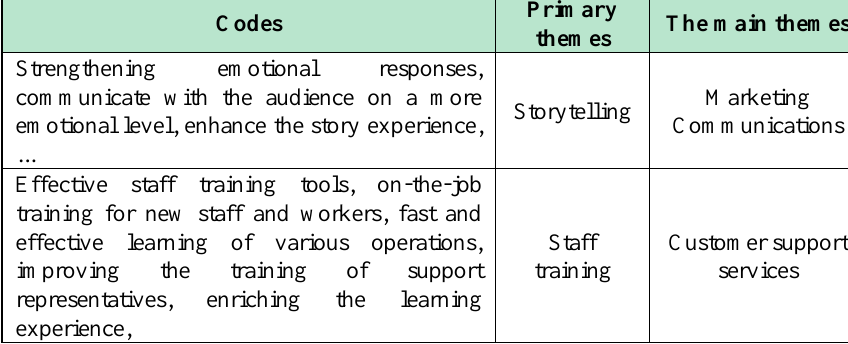
Table 2 - Sample content Themes of articles